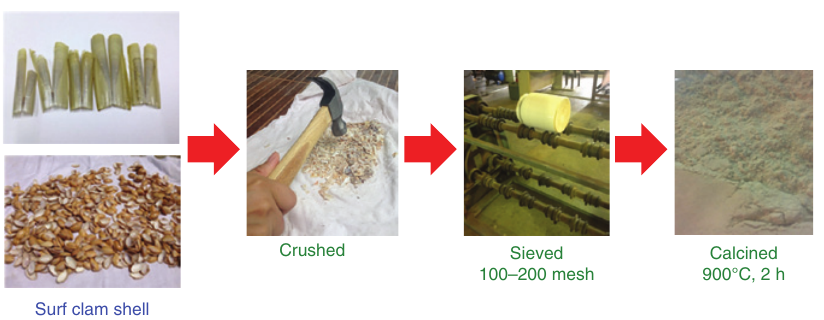
Figure 1: Preparation of CaO catalyst derived from razor and surf clam